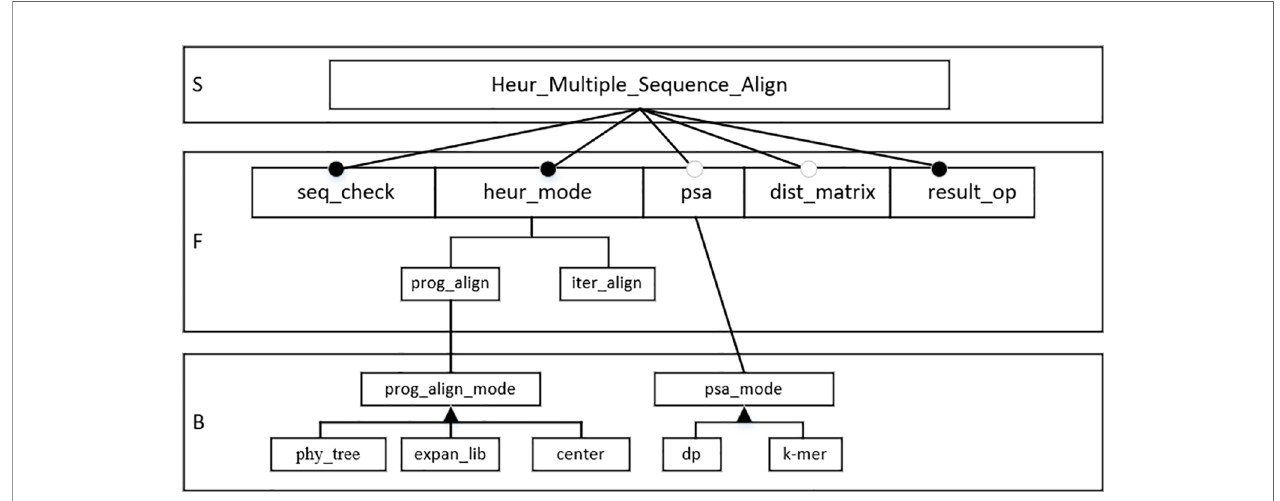
FIGURE 3 | Feature model of heuristic multiple sequence alignment algorithm